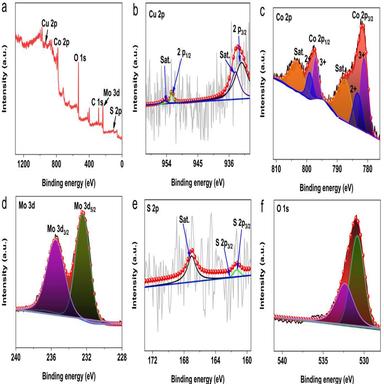
Varying XPS spectra for different CuCo2S4@CoMoO4/NF components: (a) a general survey and (b) Cu 2p, (c) Co 2p, (d) Mo 3d, (e) S 2p, and (f) O 1s regions.